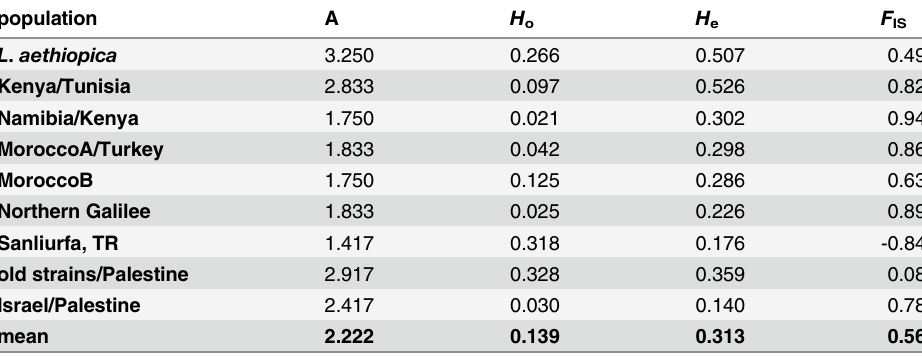
Table 2. Descriptive statistics per